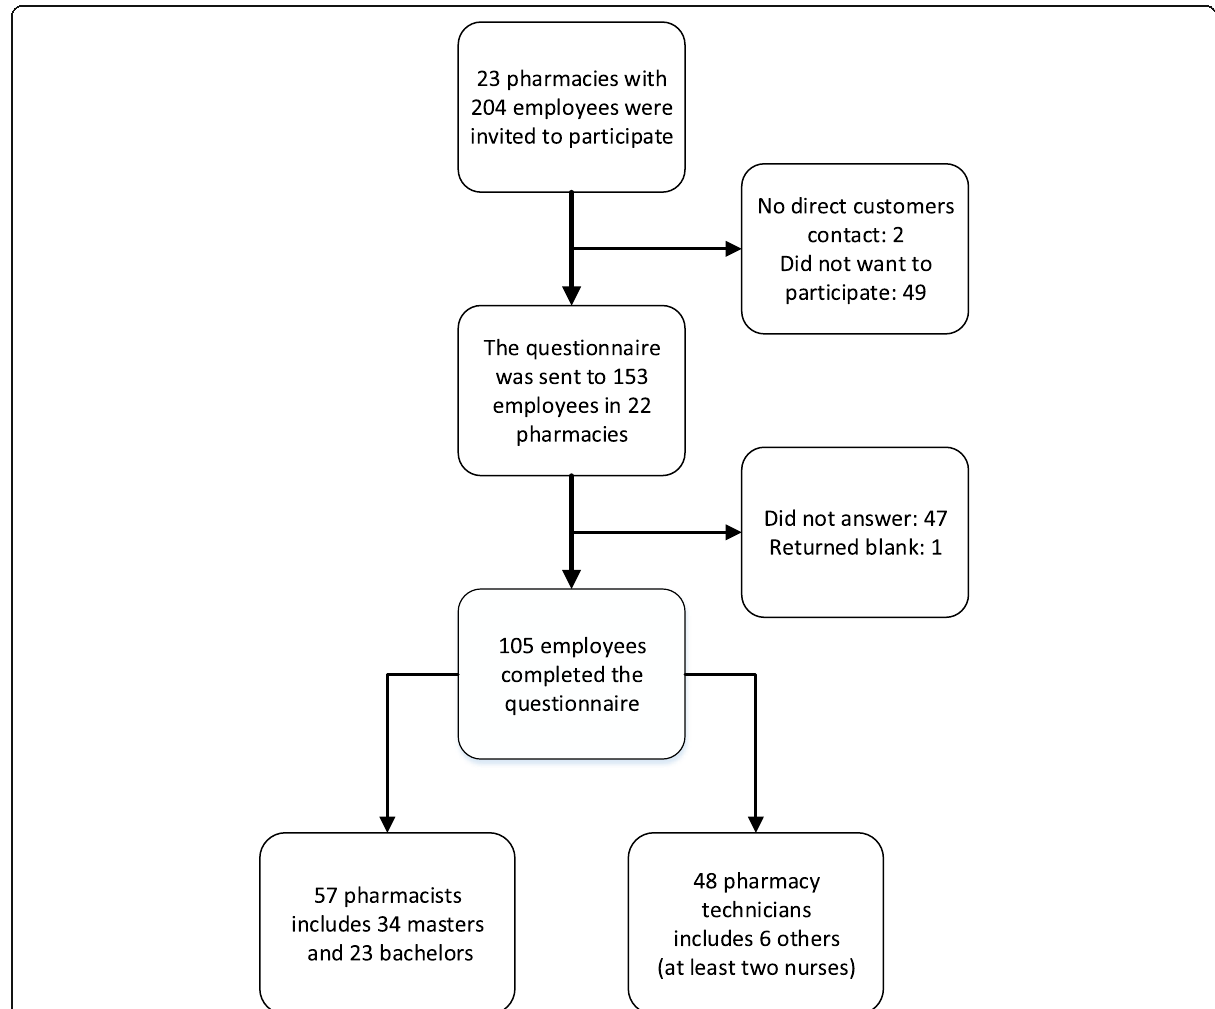
Fig. 1 Flowchart of study population and recruitment